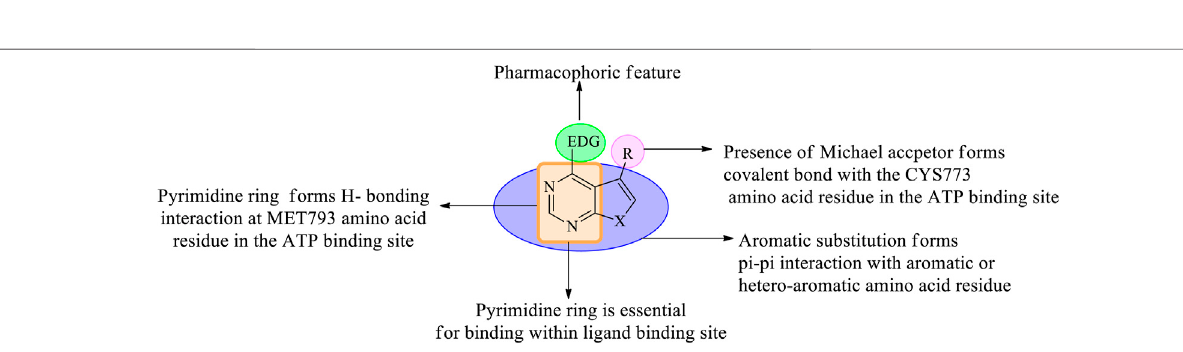
Frontiers in Chemistry |